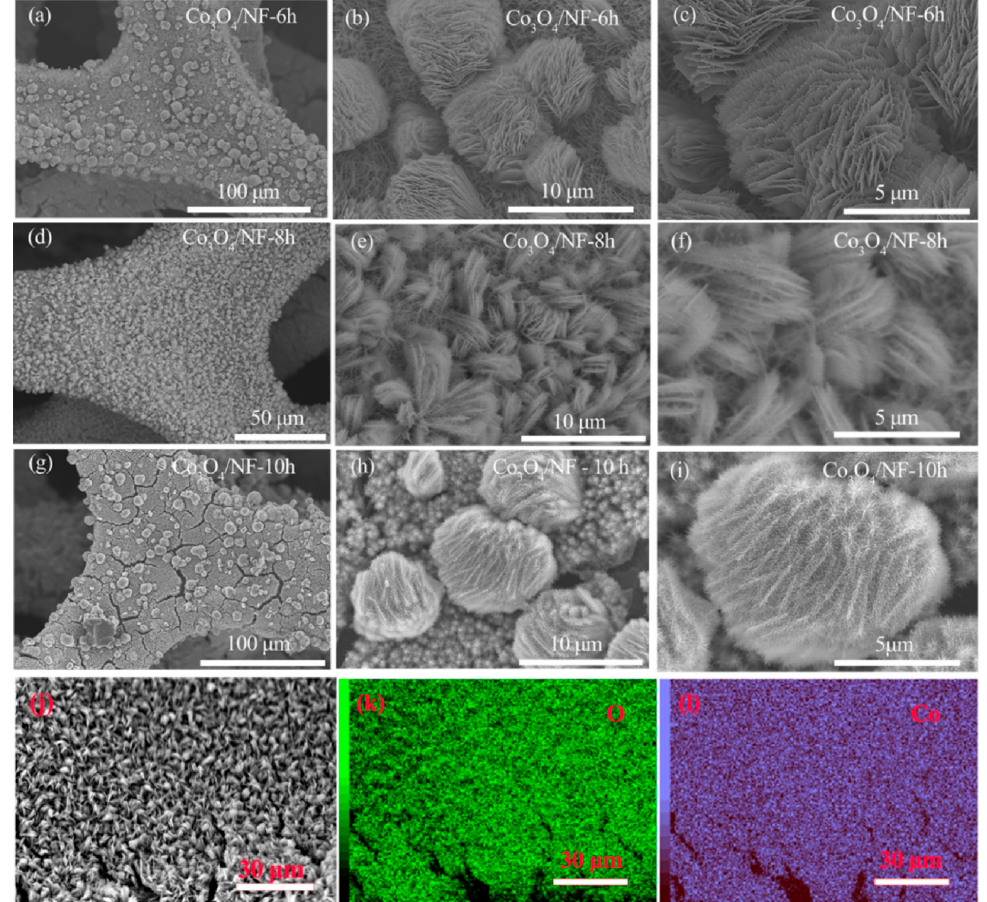
Figure 3. SEM images: ( a – c ) Co 3 O 4 /nickel foam (NF)—6 h; ( d – f ) Co 3 O 4 /NF—8 h; ( g – i ) Co 3 O 4 /NF—10 h; ( j – l ) element mapping images of Co 3 O 4 nanoflakes, reproduced with permission from [93] Copyright 2021 Elsevier. NF, Ni foam.